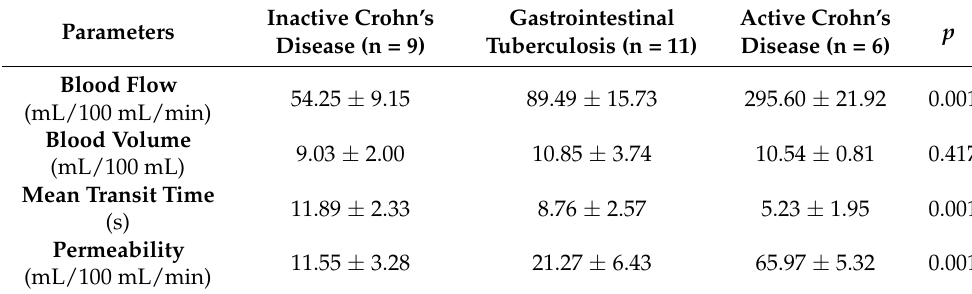
Table 1. Mean perfusion CT parameters in the three groups.